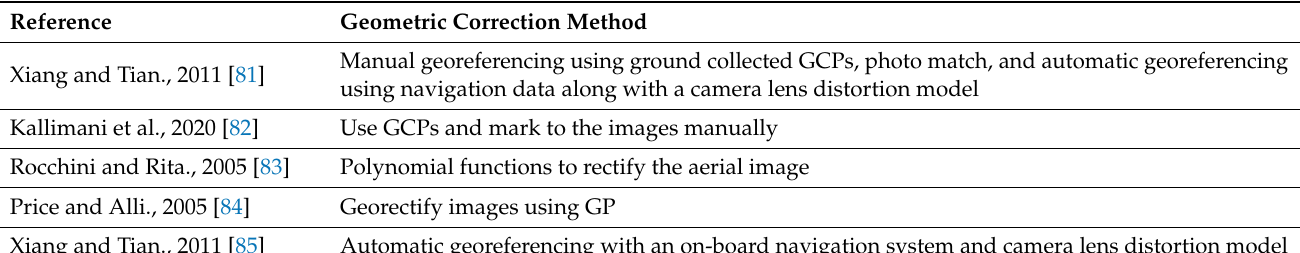
Table 9. Some of the Studies of geometric correction